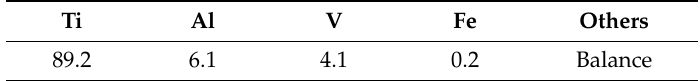
Table 1. The chemical composition of Ti6Al4V titanium alloy (weight %).